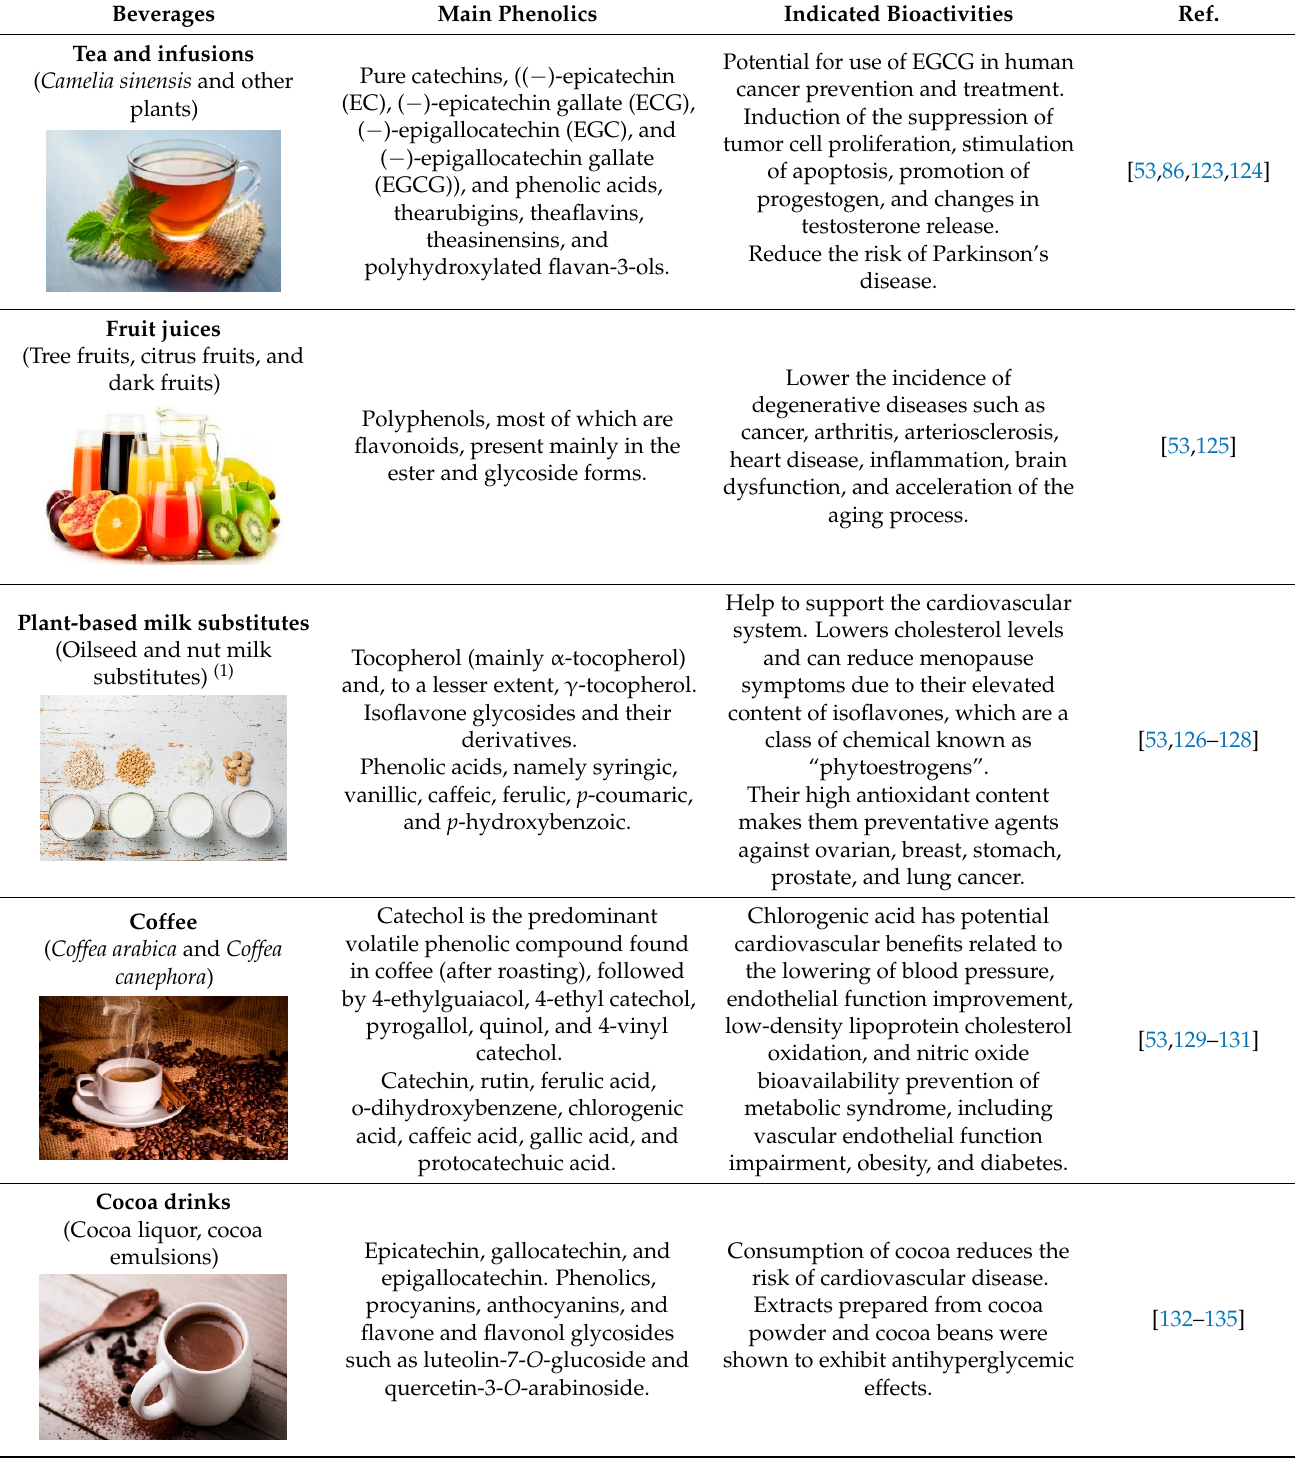
Table 5. Alcoholic and nonalcoholic beverages, their main phenolic compounds present and indicated bioactivities.